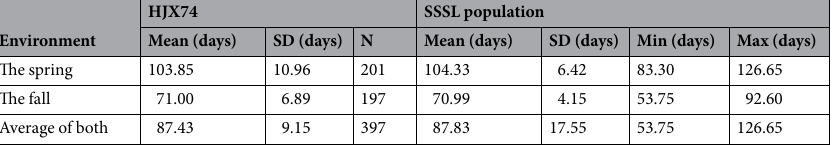
Table 1. Descriptives of heading date for Hua-jing-xian 74 (HJX74) and single segment substitution line (SSSL) population in the spring and the